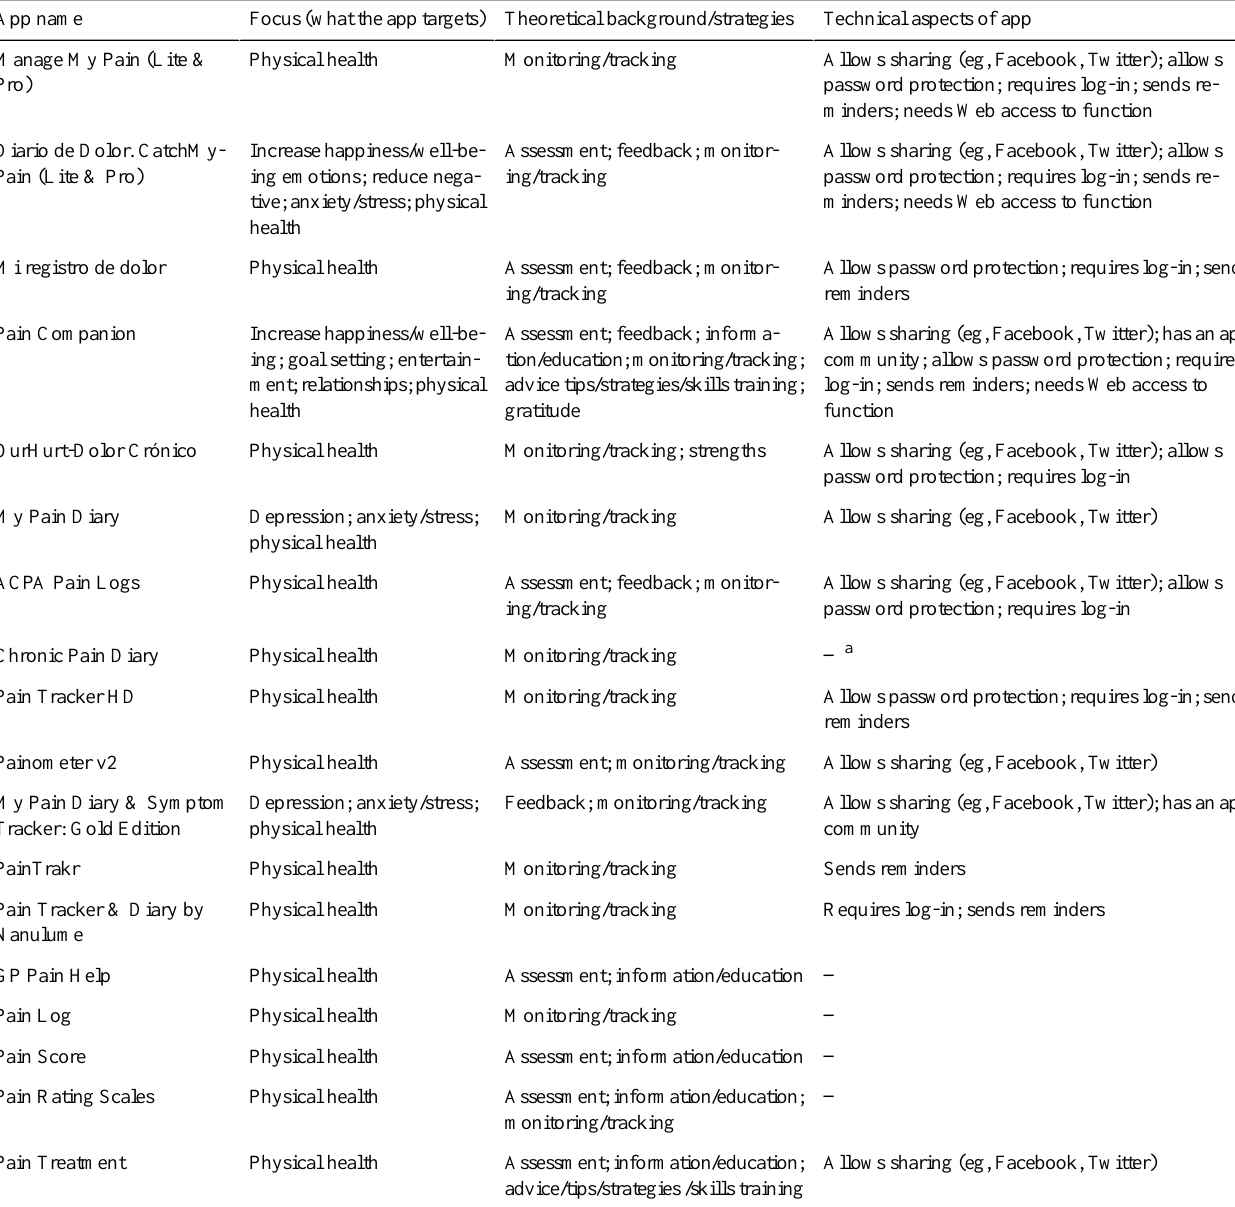
Table 3. Characteristics of the included pain-related